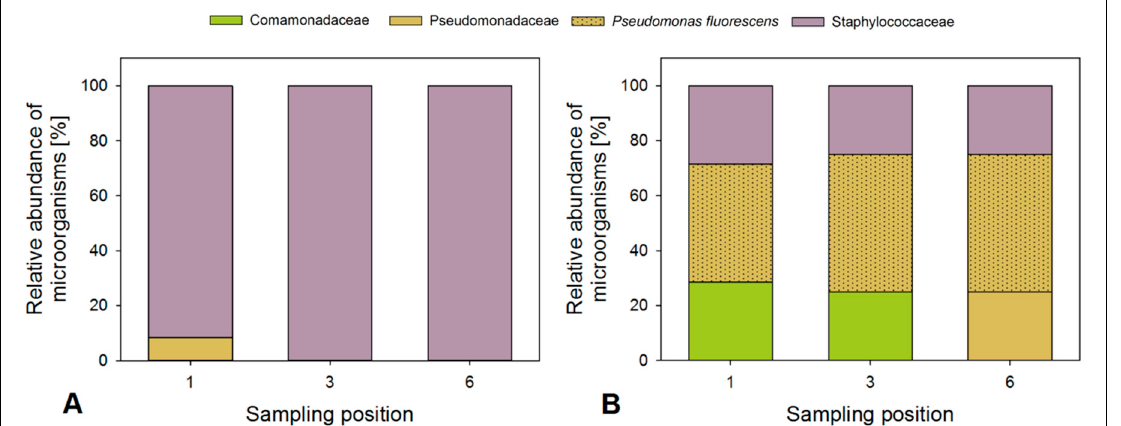
Figure 4. Culturable microbial community structure of endive lettuce (identified colonies only) along the washing process chain. The washing was conducted with the addition of PTW in the pre-rinsing step (30 s) (trial C) and the samples were analyzed after washing ( A ) and after storage for seven days at 2 °C ( B ). Sampling positions: (1) endive raw material; (3) endive after pre-rinsing; (6) endive after final rinsing.